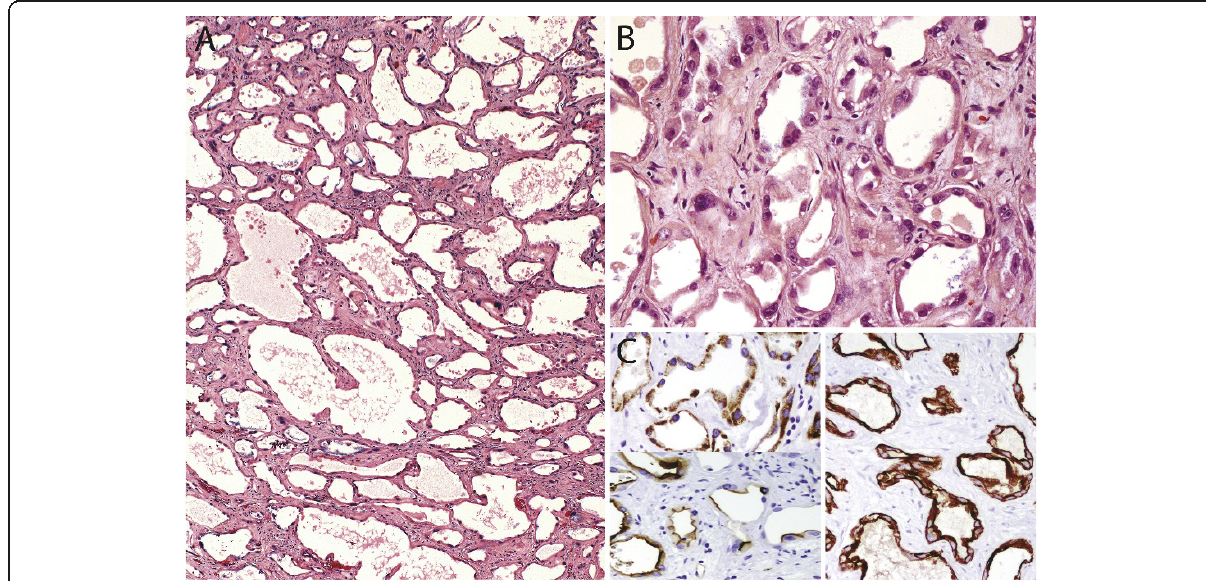
Figure 3 Tubulocystic carcinoma component . A ) Higher magnification of the image shown on figure 2B (H&E, 4×). B ) The cystically-dilated tubules were lined by flat to polygonal cells (some with a hobnail profile) with enlarged nucleus, prominent nucleolus, and occasional abundant eosinophilic cytoplasm. The fibrous septae contained scattered fibroblast-like spindle cells interspersed within a collagenous stroma (H&E, 20×). C) Tubular cells were positive for AMACR (left, top) and CD10 (left, bottom), and CK19 (right) confirming their proximal and distal convoluted tubule cell origin, respectively (all images, 20×). Estrogen receptor was negative in both epithelial and stromal elements (not